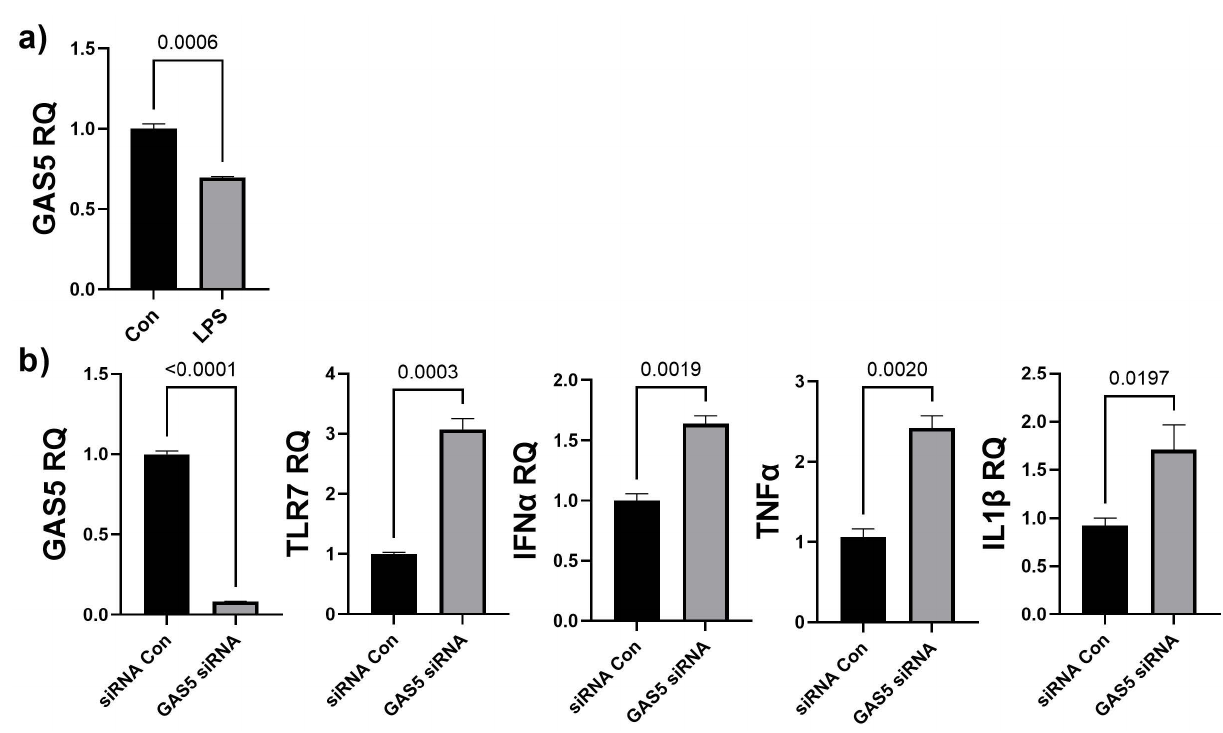
Figure 5. ( a ) HDF cells were treated with 5 ng/mL LPS for 4 days. SYBR Green real-time qPCR was performed using GAS5 primers. Relative quantification (RQ) was determined using a control sample as reference ( n = 3). Statistical analysis was performed by t -test and significant p -values (<0.05) are indicated on the graph. ( b ) GAS5 was depleted in HDF cells by transfecting 25 nM GAS5 siRNA or negative control siRNA (siRNA Con) for 48 h. RNA was isolated and real-time qPCR was performed using primers specific for GAS5, TLR7, IFN α , IL1 β , or TNF α . Relative quantification (RQ) was determined using a control sample as reference ( n = 3). Statistical analysis was performed by t -test and significant p -values (<0.05) are indicated on the graph.